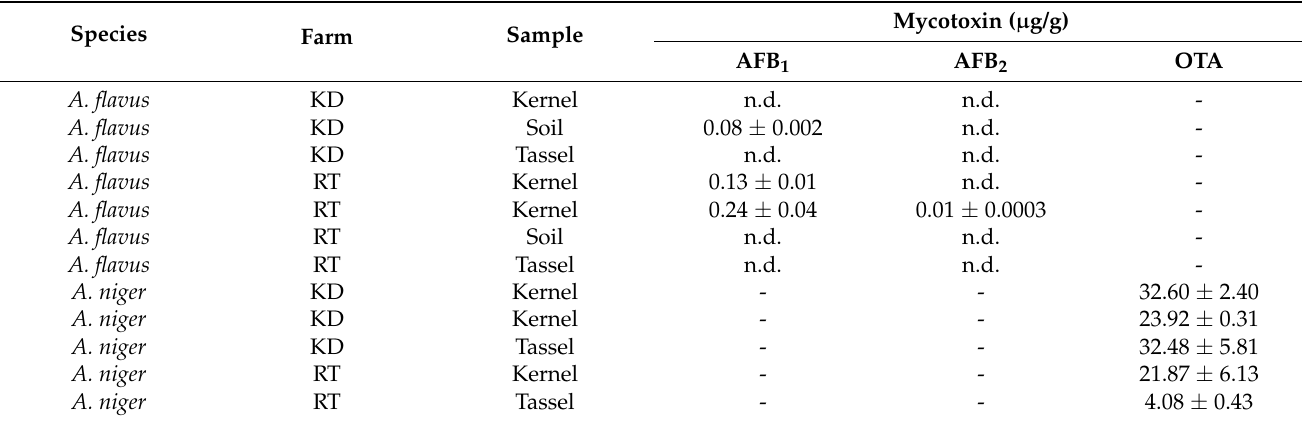
Table 4. Aflatoxins and ochratoxin A ( µ g/g) production by Aspergillus flavus and A. niger isolate, respectively, recovered from Kampong Dadong and Rhu Tapai grain corn farms in Terengganu.